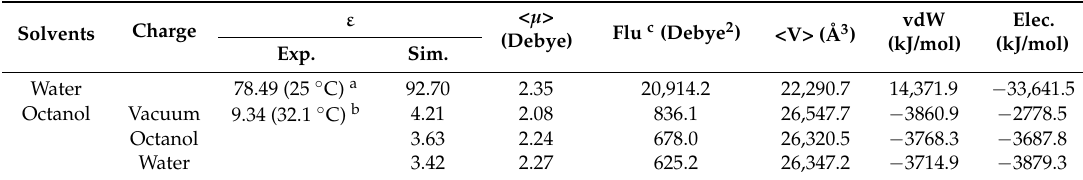
Table 3. Properties of solvents in